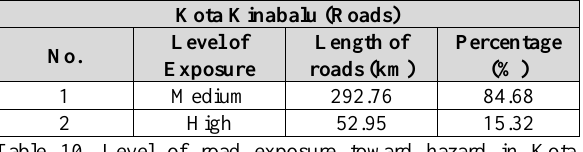
Table 10. Level of road exposure toward hazard in Kota Kinabalu